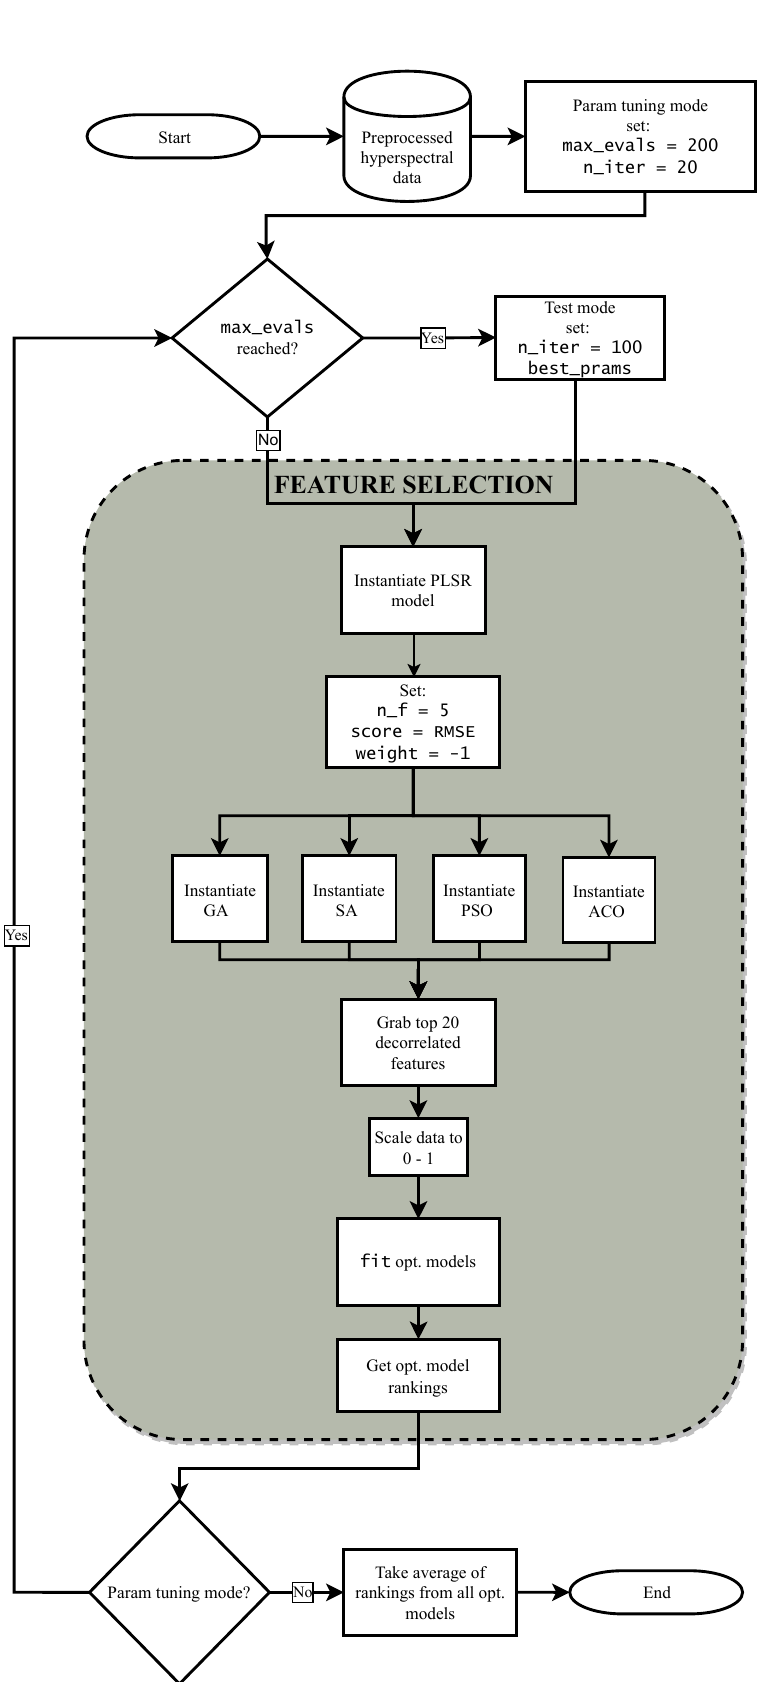
Figure 5. Flowchart of the steps employed for data analysis of the preprocessed hyperspectral